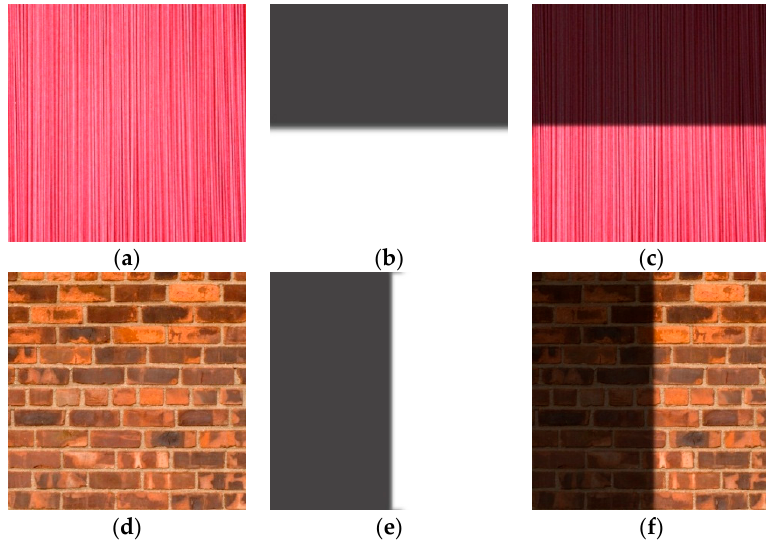
Figure 7. Synthetic example. ( a , d ) original image; ( b , e ) simulated illumination; ( c , f ) synthetic image. Sensors 2016 , 16 , 832